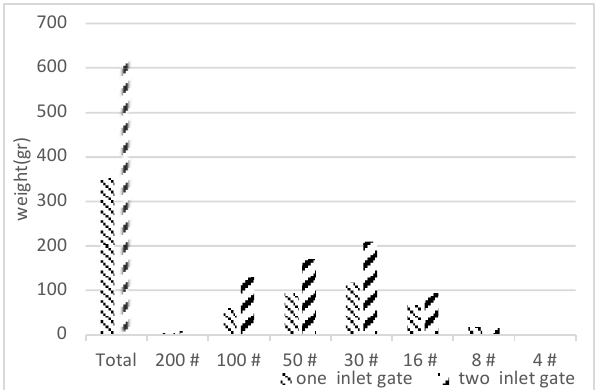
Fig. 8. The amount of separated sand in hydrocyclone with one and two inlet gates